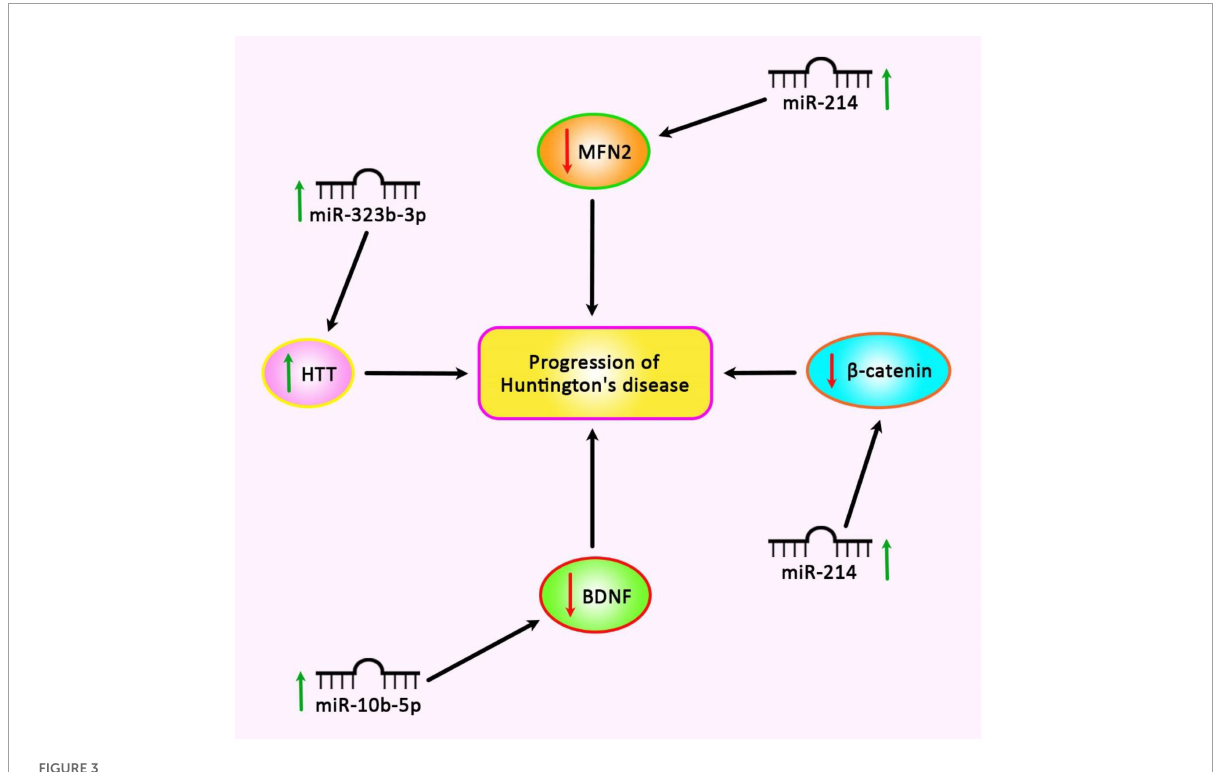
FIGURE3 Up-regulation of miR-214, miR-322b-3p, and miR-10b-5p is involved in the pathogenesis of Huntington’s